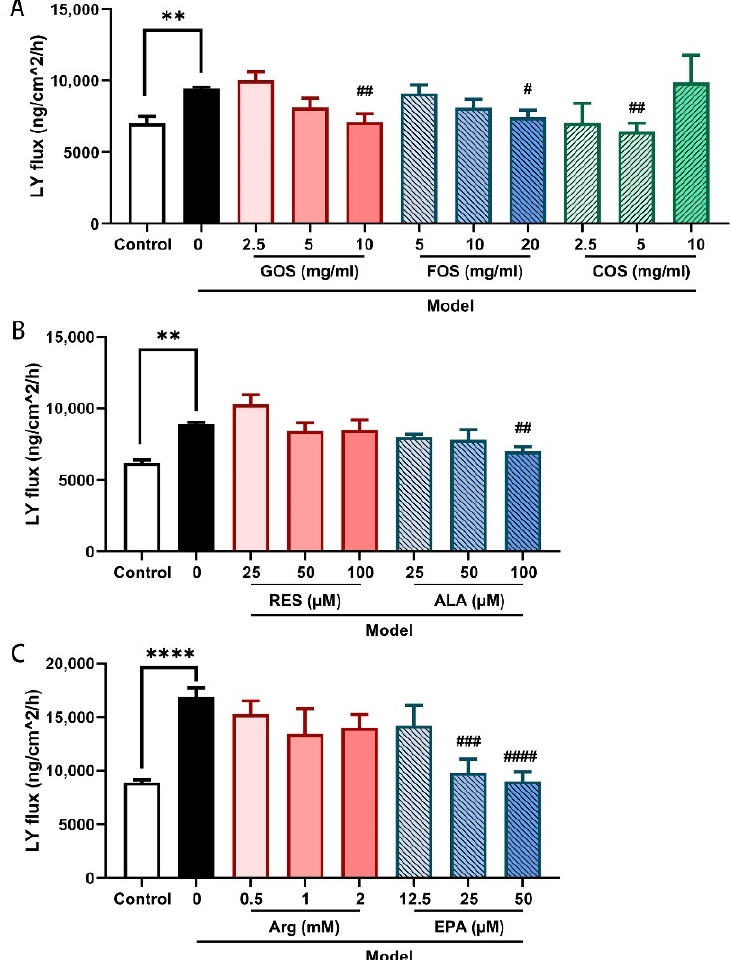
Figure 3. Lucifer Yellow flux of Caco-2/HT-29 cell monolayers pre-incubated with GOS, FOS, COS, ( A ), RES, ALA ( B ), Arg, and EPA ( C ) for 48 h then exposed to hypoxia and heat treatment (2 h). After hypoxia and heat treatment, Lucifer Yellow was added to the apical compartment, and the fluorescent intensity of the medium in the basolateral compartment was measured 4 h after application. All values were presented as means ± SEM (N = 3, n = 2 (GOS, FOS, COS group), and n = 3 (all other groups)). Statistical differences were analyzed by two-way ANOVA followed by the Bonferroni’s multiple comparison test. ** p < 0.01 and **** p < 0.0001 versus control; # p < 0.05, ## p < 0.01, ### p < 0.001, and #### p < 0.0001 versus model. LY, Lucifer Yellow; GOS, galacto-oligosaccharides; FOS, fructo-oligosaccharides; COS, chitosan oligosaccharides; ALA, α -lipoic acid; RES, resveratrol; Arg, l-arginine; EPA, eicosapentaenoic acid. The detailed fluorescent readings are listed in Table S3.